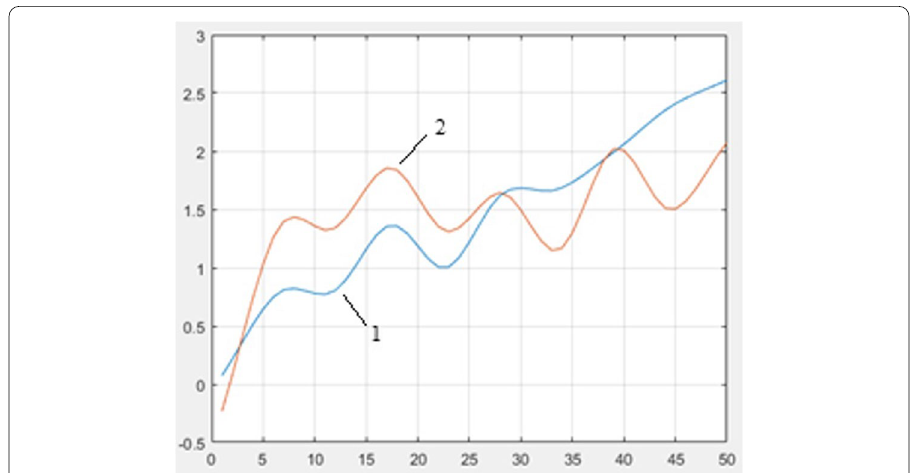
Fig. 9 The result of KQI parameter alignment: 1—curve of approximated values; 2—curve of aligned